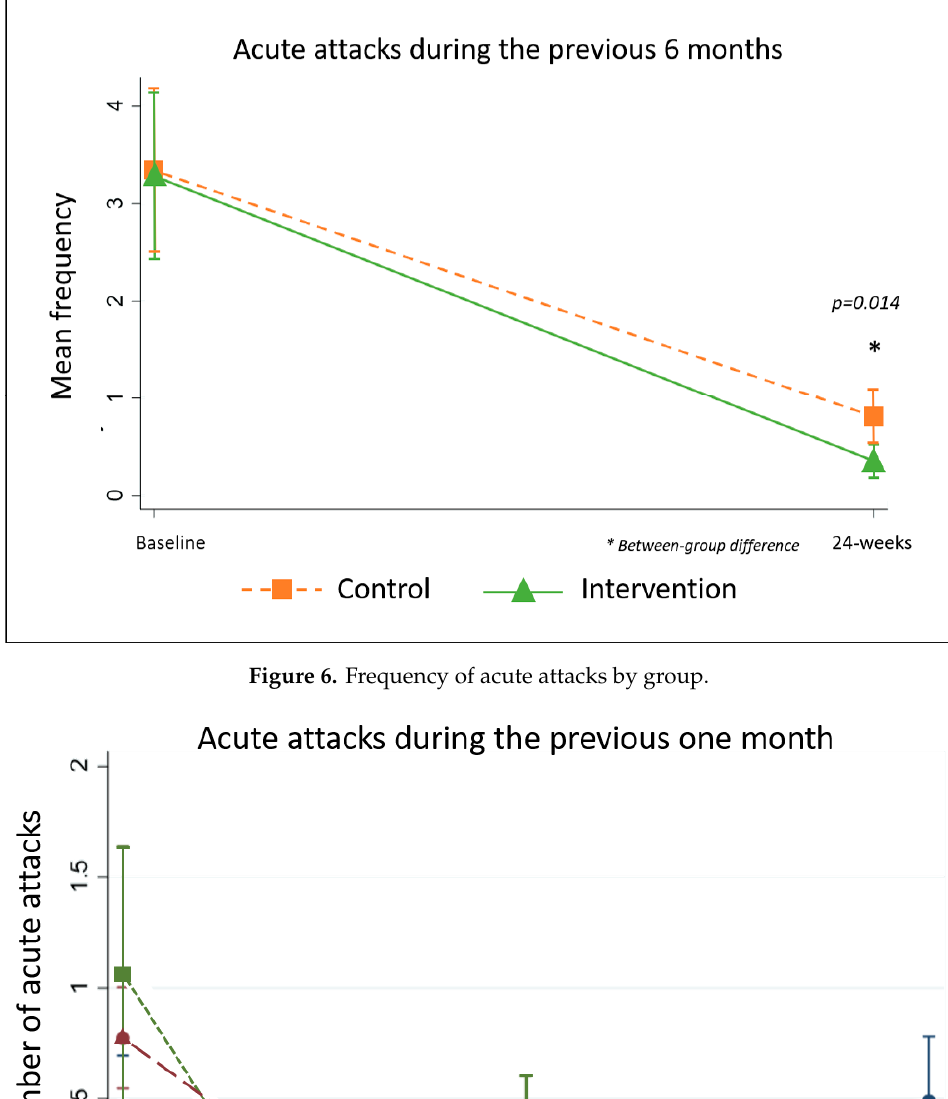
Figure 7. Frequency of acute attacks by